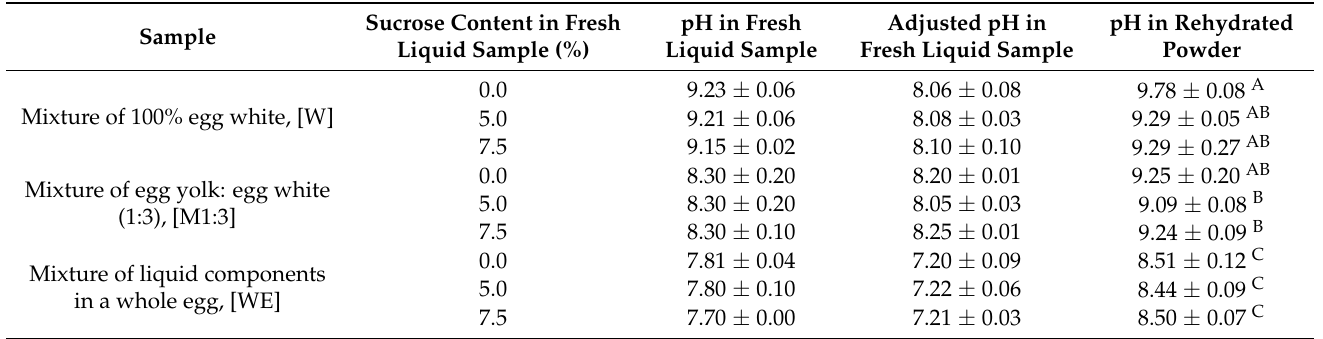
Table 2. The behavior of egg sample pH before and after